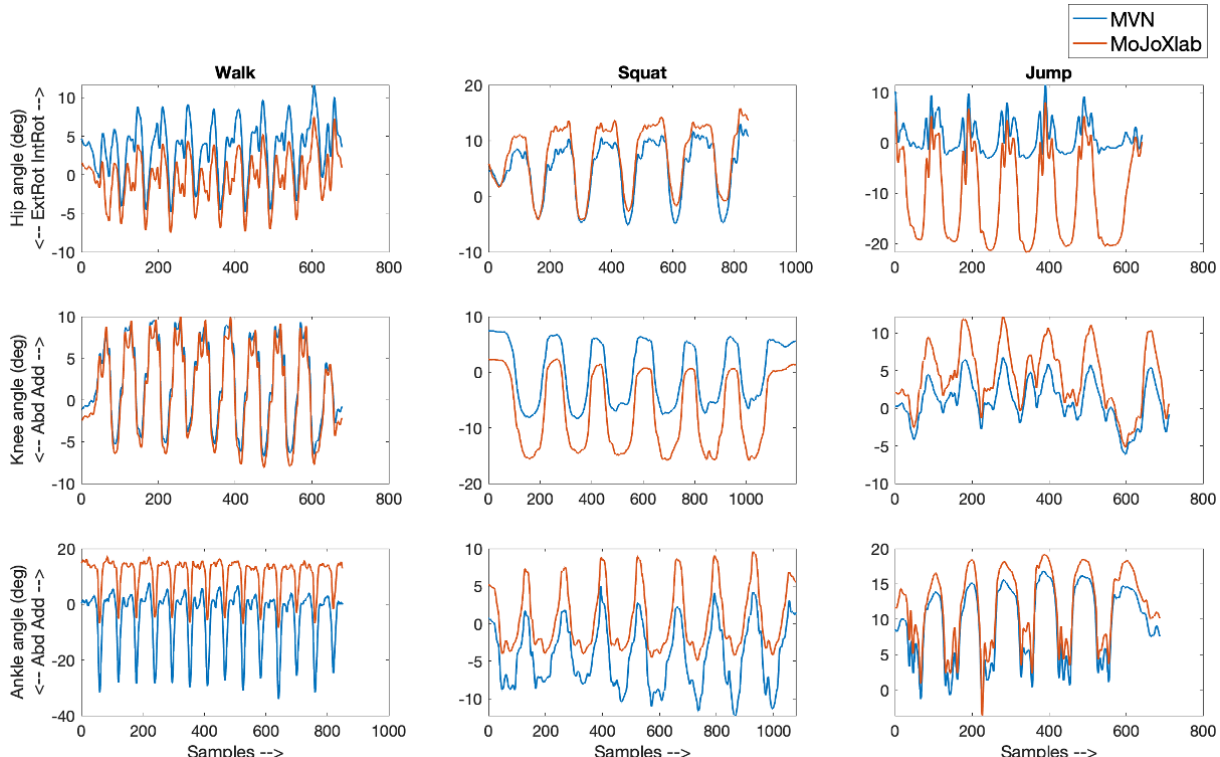
Figure 6. Representative frontal plane joint angle waveforms selected from the anterior cruciate ligament reconstruction participant data set. Waveforms for the hip (top row), knee (middle row), and ankle (bottom row) joint angles obtained from MVN Analyze (blue), and our custom software MoJoXlab (orange) for walking (left), squatting (center), and jumping (right) tasks. The y-axis represents joint angles in degrees, and the x-axis represents data samples across the entire